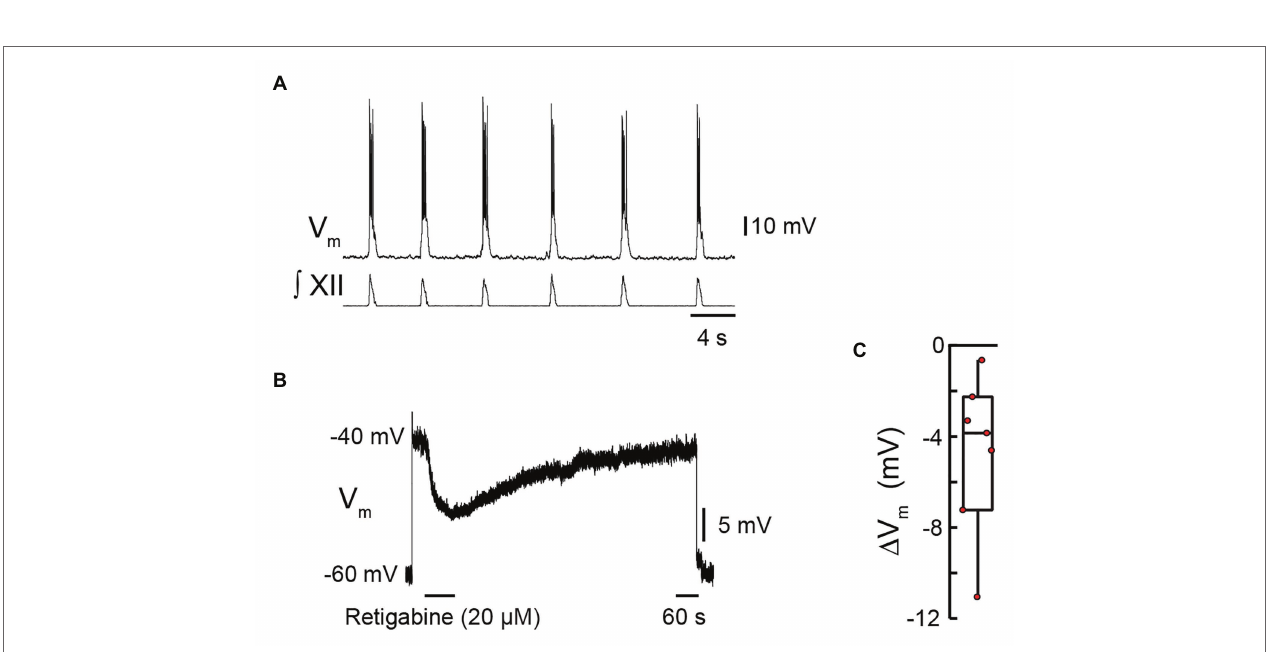
FIGURE 2 | Effects of retigabine, a KCNQ channel activator, on membrane potential of inspiratory pre-Bötzinger complex (preBötC) neurons. Current clamp recording from a preBötC inspiratory neuron showing depolarization and bursts of action potentials in phase with inspiratory bursts recorded from the XII nerve prior to bath application of tetrodotoxin (TTX; 0.5 μ M) and ZD7288 (10 μ M). (B) Current-clamp recording from the same neuron in (A) in the presence of TTX and ZD7288, showing that when the neuron is depolarized from − 60 mV (holding) to − 40 mV via injection of D.C. current, local application of retigabine (20 μ M, 80 s) caused membrane hyperpolarization. (C) Group data showing maximum change in membrane potential evoked by local application of retigabine (box plot: median and interquartile range; whiskers: 10th and 90th percentiles) and individual values (red circles), n =